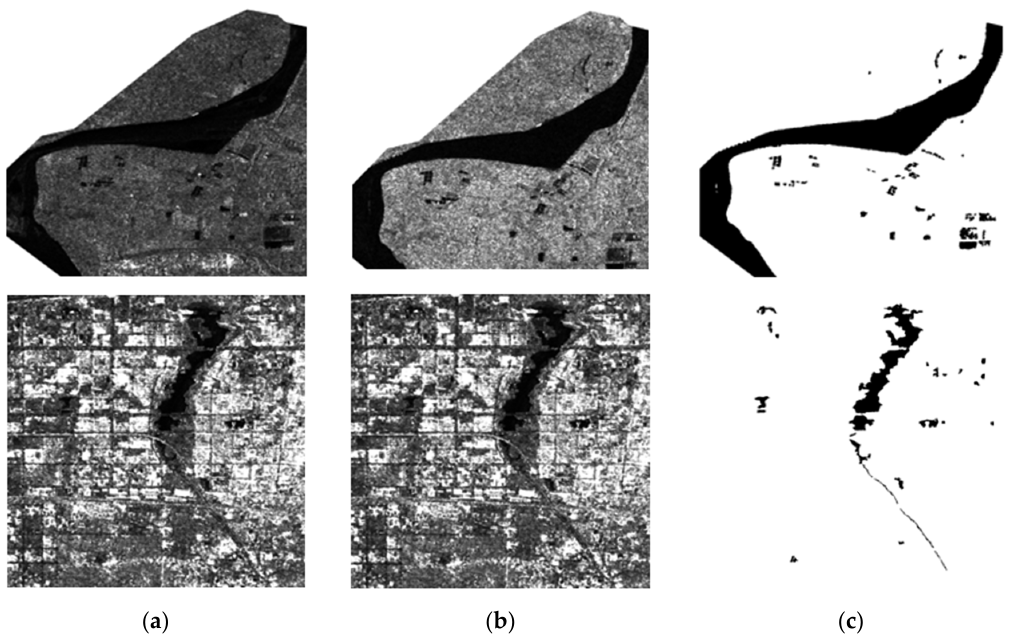
Figure 3. The images and training samples from Sentinel-1A. ( a ) BF of VV polarization. ( b ) BF of VH polarization. ( c ) Corresponding training samples.